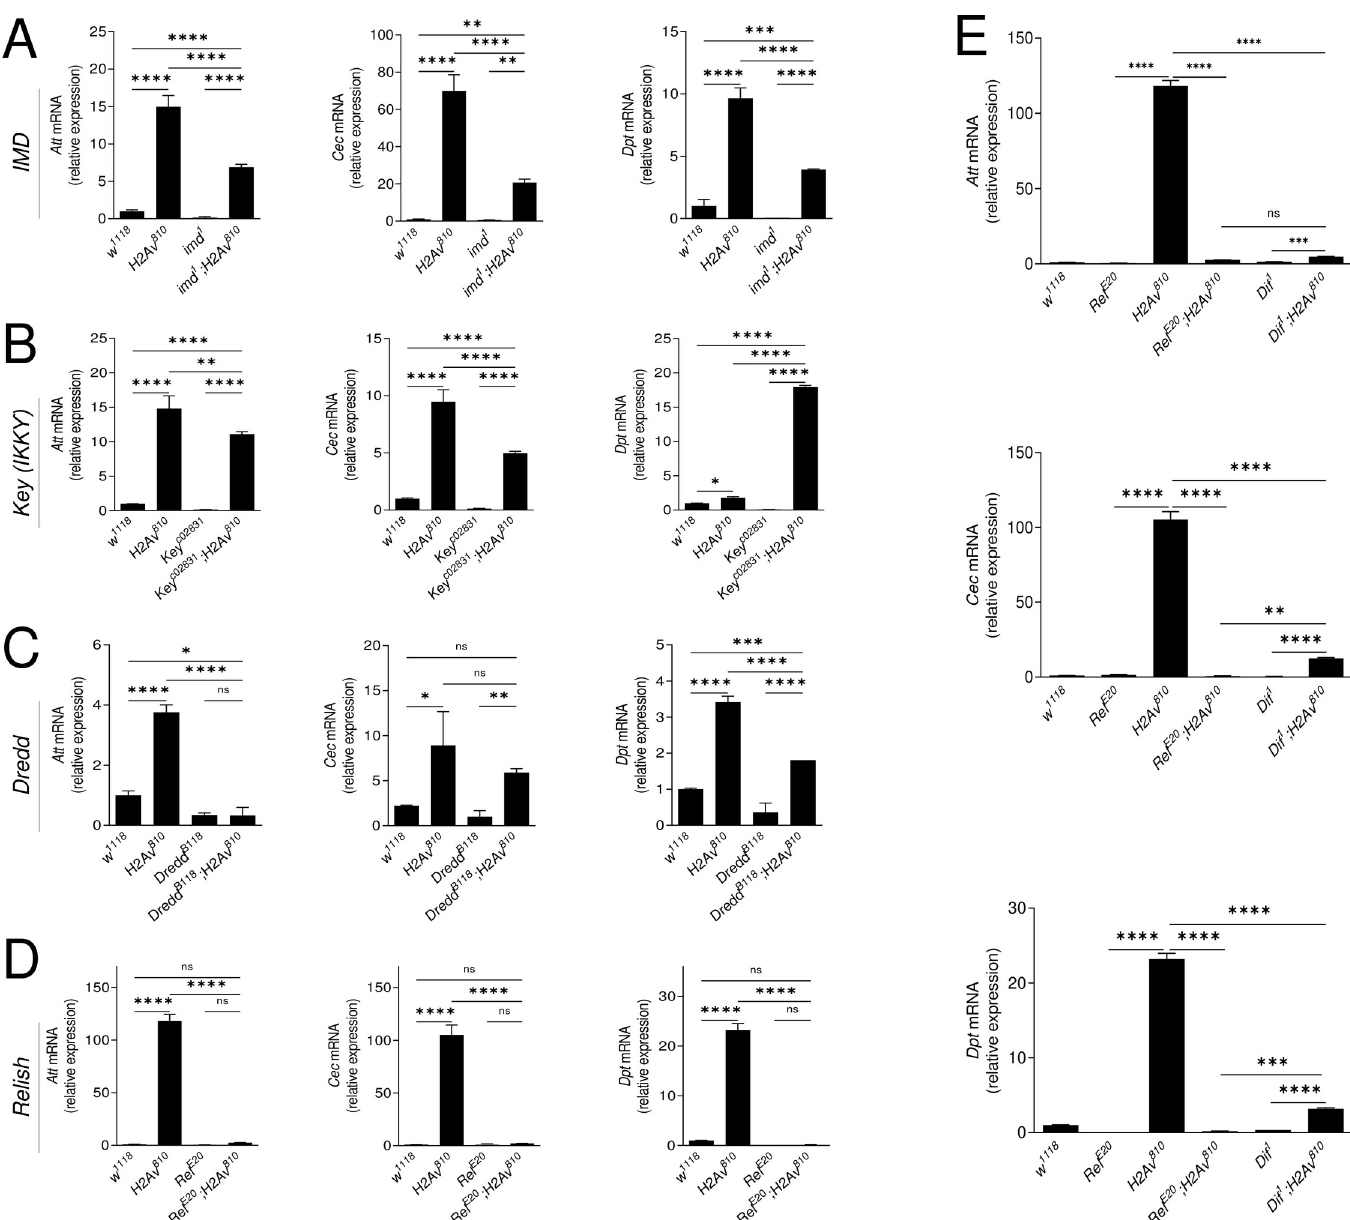
Fig 2. Epistatic relationship between H2Av and IMD pathway components. Homozygous H2Av 810 / H2Av 810 flies were crossed with mutants of the main IMD pathway components (A, imd 1 ; B, Key c02831 ; C, Dredd B118 ; D, Rel E20 ). A mutant of the Toll pathway component Dif ( Dif 1 ) was also crossed to analyze the relationship between Toll and H2Av (E). AMP transcription was assessed by qPCR on fat bodies of second-instar larvae. All genotypes are homozygous. Data represent the average of at least three independent assays (mean ± SE). One way ANOVA with Tukey’s multiple comparisons test was performed. � p < 0.05, �� p < 0.01, ��� p < 0.001, and ���� p < 0.0001.